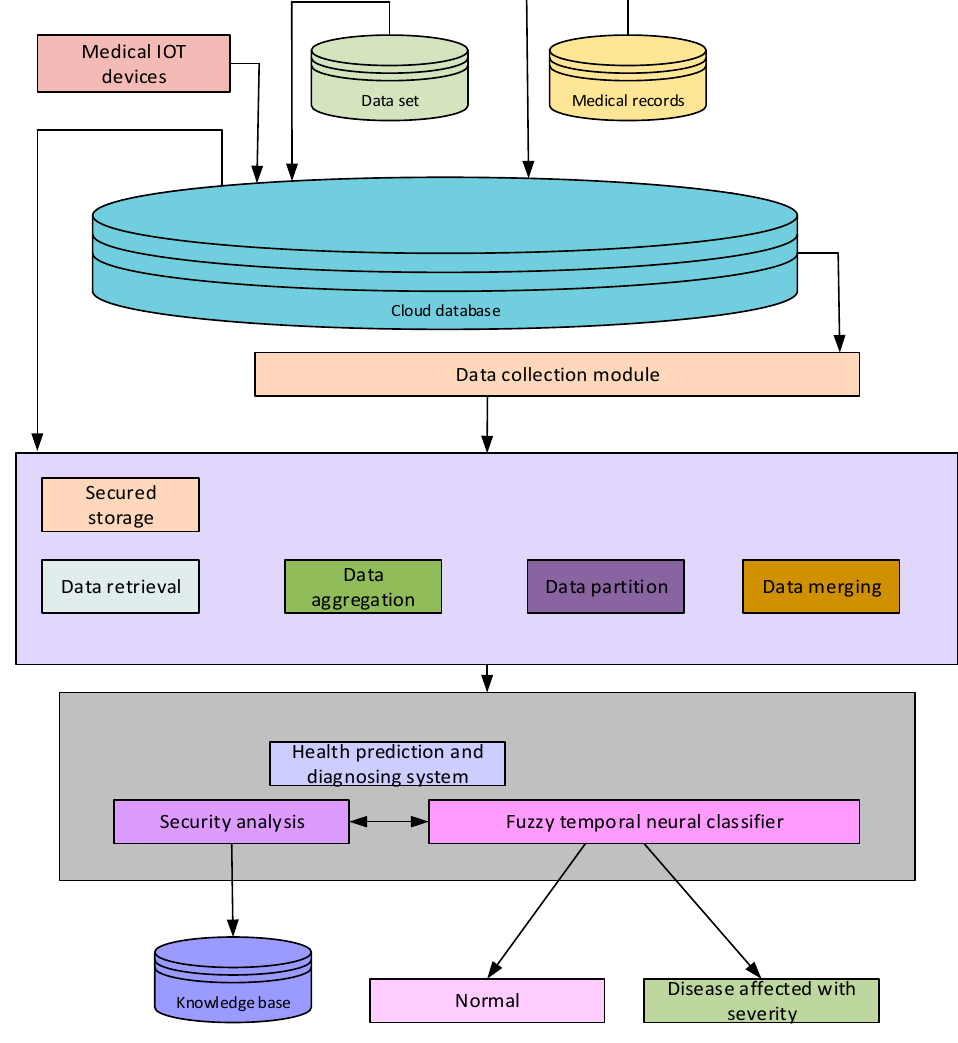
Figure 1. System